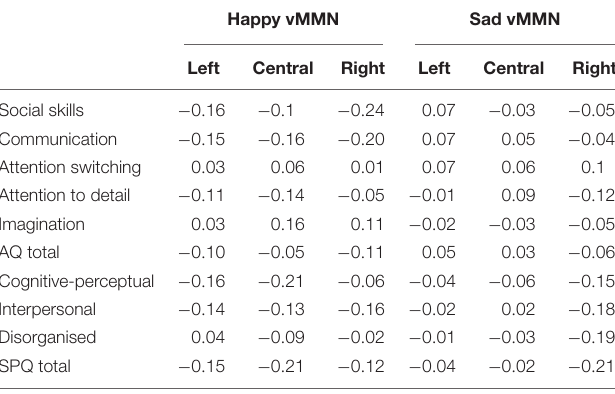
TABLE 3 | Spearman rank order correlations between full-scale autism spectrum quotient and schizotypal personality questionnaire dimension scores and average visual mismatch negativity amplitudes when the mismatch response was calculated for happy and sad deviants relative to neutral